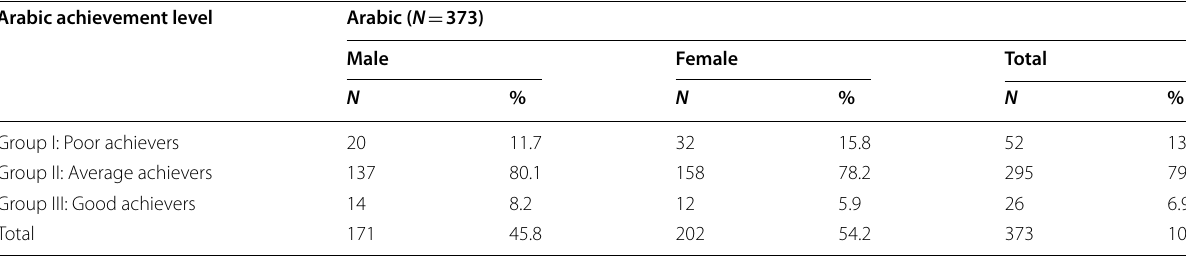
Table 1 Reading achievement level of 2nd-grade public school students Arabic achievement level